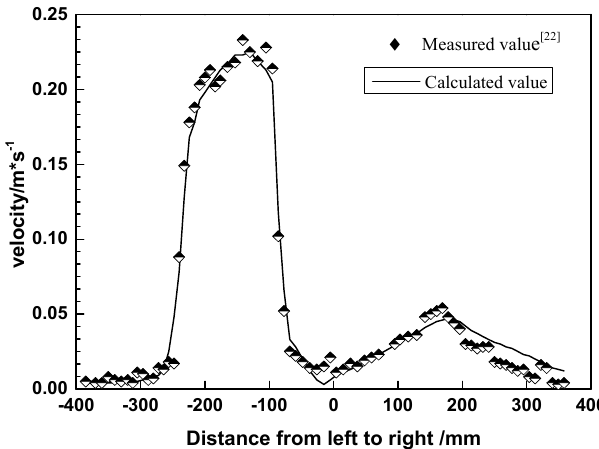
Figure 6. Velocity distribution at a height of 500 mm from the bottom of the ladle.